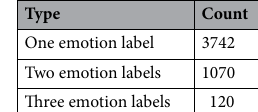
Table 2. Count of instances with single and multiple emotion